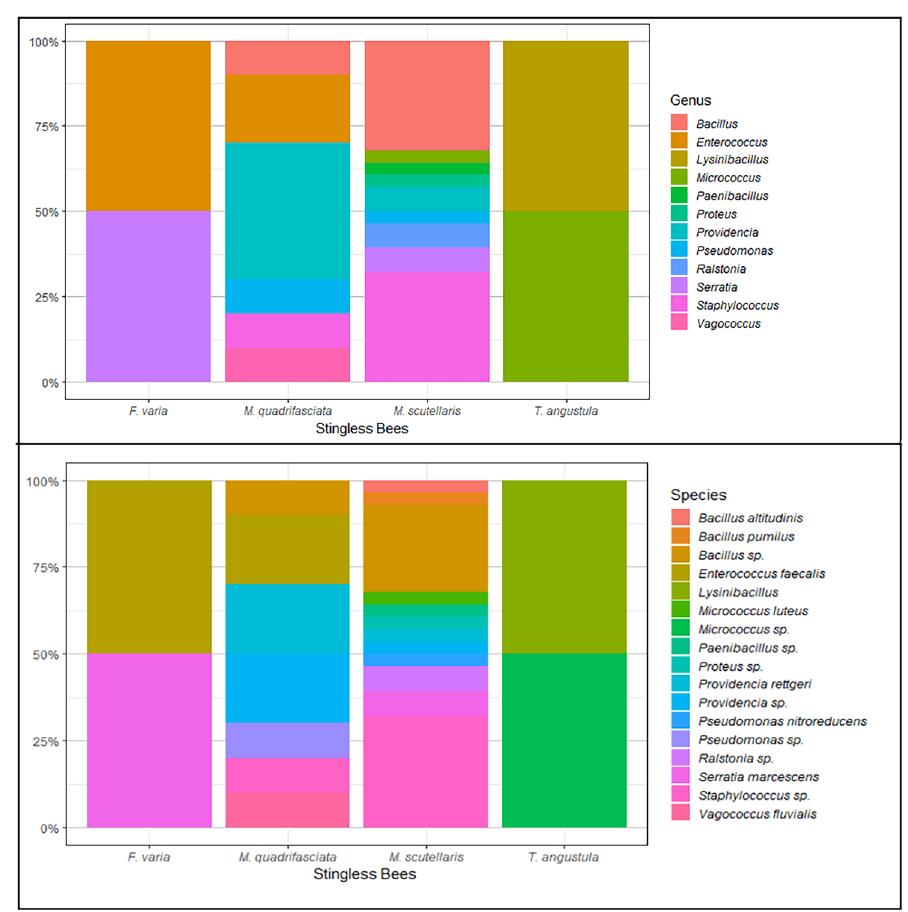
Figure 5. ( A ) Abundance of genera bacterial isolated from larval food of stingless bees. ( B ) An abundance of species was found from the larval food of stingless